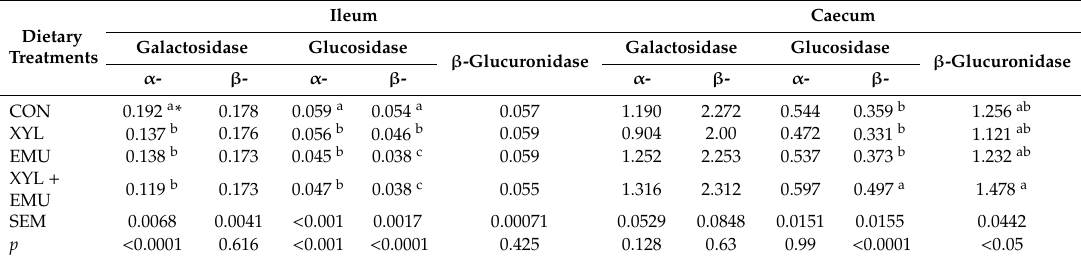
Table 4. The activity of the bacterial enzyme [U / g] 1 in ileal and cecal digesta in birds fed control (CON), control supplemented with xylanase (XYL), control supplemented with an emulsifier (EMU), and control diet supplemented with xylanase and emulsifier XYL + EMU.